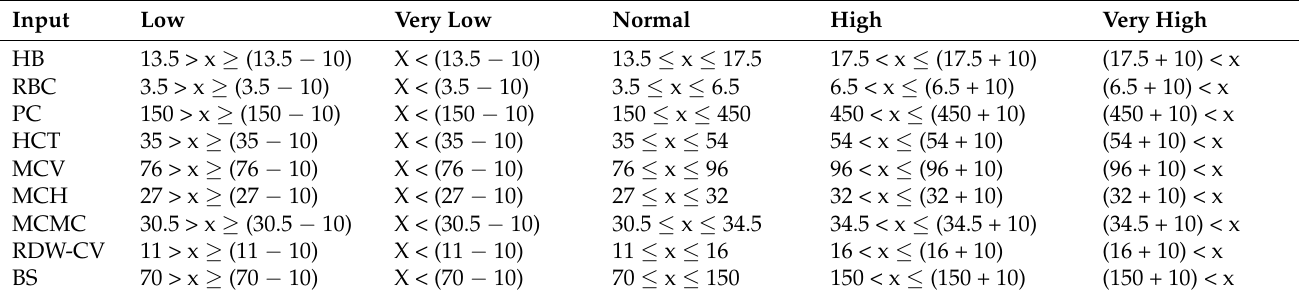
Table 7. Range Limit of Linguistic Variables and the Corresponding of Input data.